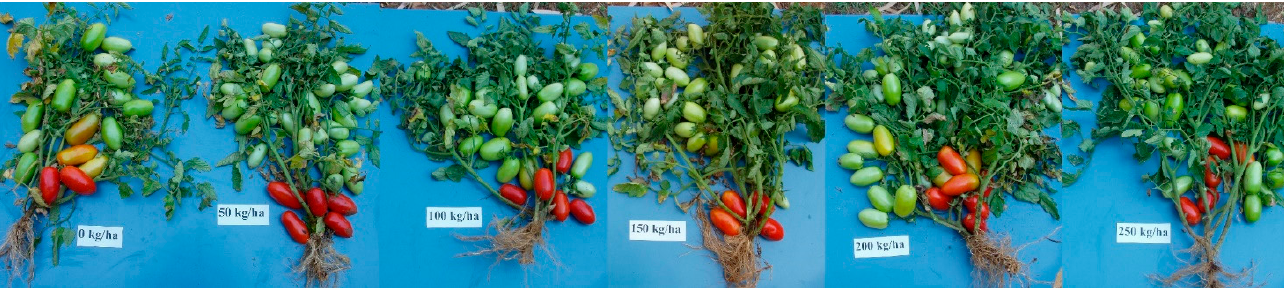
Figure 2. Visual comparison of cv “Messapico” plants treated with different nitrogen rates (N-50, N-100, N-150, N-200, and N-250) compared with control (N-0). Photos taken at 90 days after transplanting.